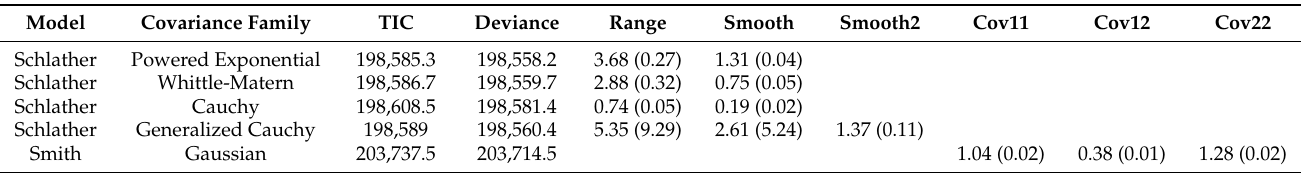
Table 3. Max-stable process fitted to the first cluster of the average annual precipitation.